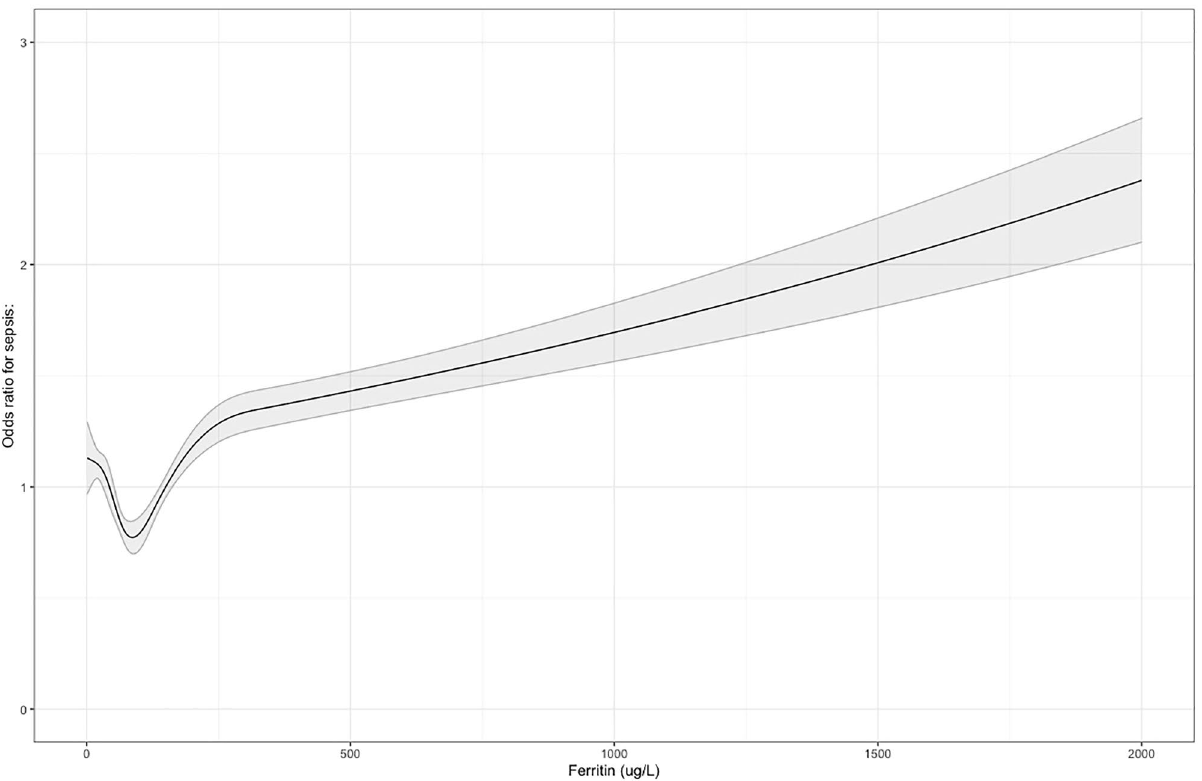
Figure 1. Restricted cubic spline plots of ferritin level and odds ratio for sepsis. The dashed line represents an odds ratio of 1, representing a null